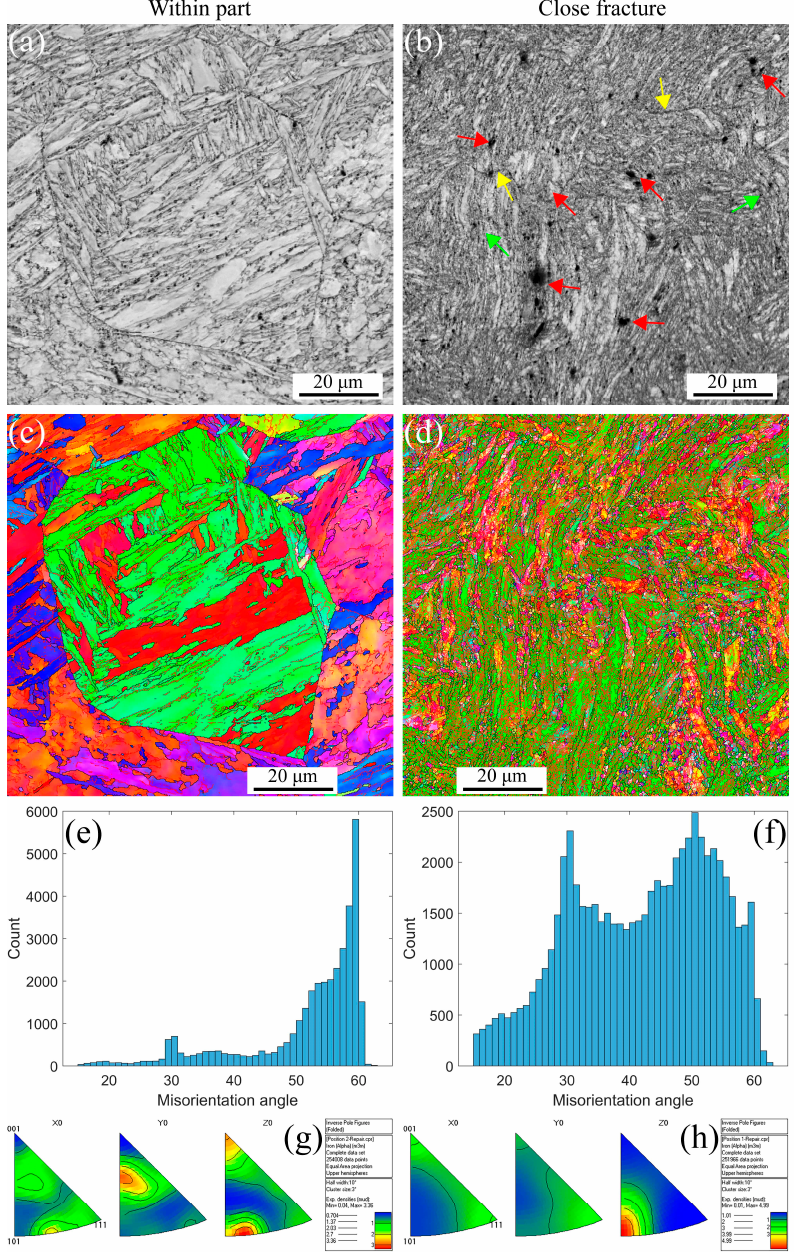
Figure 9. EBSD maps under different strain gradients at the strain rate of 5 × 10 − 5 s − 1 under RT (Red arrows indicate voids within the grain and along the line, green arrows indicate shrinking microstructures, and yellow arrows point to voids and shrinking cracks). ( a , b ) IQs; ( c , d ) IPFs; ( e , f ) misorientation angles; and ( g , h ) inverse polo